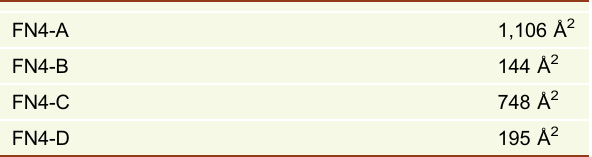
Table 1. The surface buried area of the four DCC FN4 domains on FN56